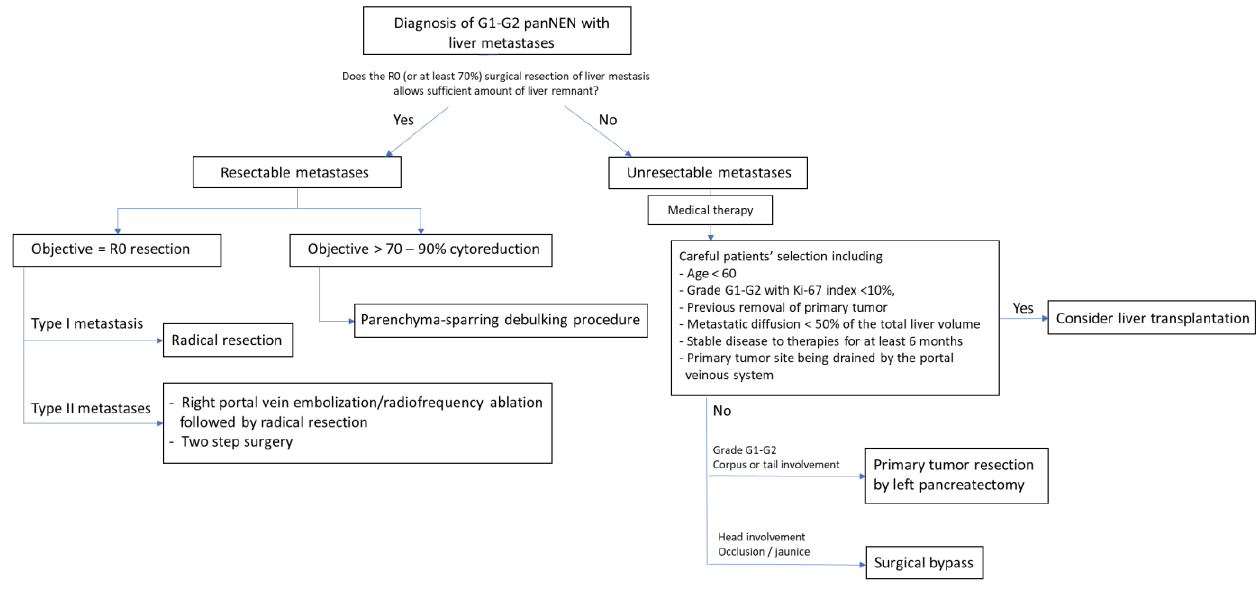
Figure 2. Surgical management for sporadic metastatic NF-panNENs (Stage IV). PanNEN: Pancreatic neuroendocrine ne- oplasm.